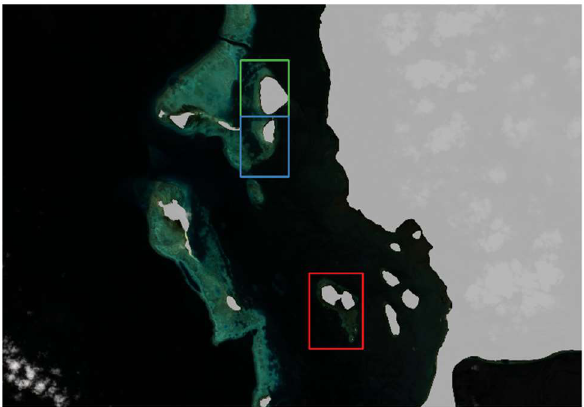
Figure 2. Area of Interest (AoI) in this study. AoI-1 (red box), AoI-2 (blue box), AoI-3 (green box).